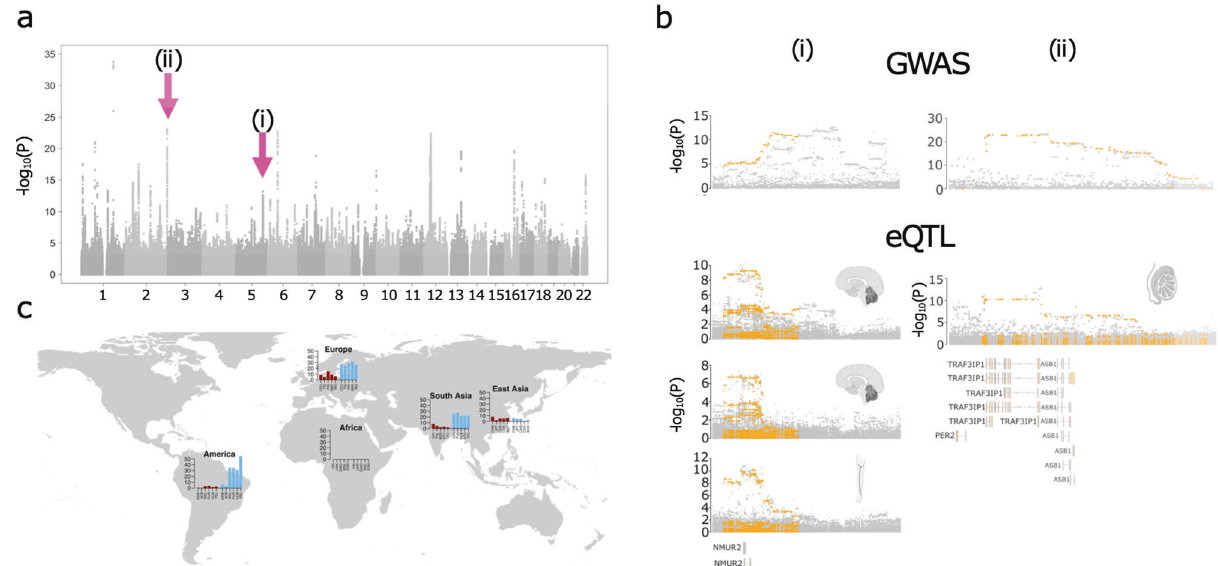
Fig. 3 Neandertal DNA contributes to chronotype risk loci. a Manhattan plot for a Chronotype GWAS in the UK Biobank. b Magni fi ed views of the association ( y -axis, − log 10 transformation of the association p value) score with chronotype on chromosomes 5 (left, chr5:151,589,813 – 152,689,813) and 2 (right, chr2:239,173,478 – 239,573,478) are shown on the top part of each panel. aSNPs are highlighted in orange. The lower part of each panel shows gene expression associations in GTEx tissues for the respective regions (eQTL − log [10] transformed association P values for — from top — Cerebellar_Hemisphere, Cerebellum and Tibial Nerve and Testis. Models of overlapping gene are illustrated at the bottom. c The frequency of the top associated aSNPs from the two illustrated regions (rs76939124, chr2:239,223,478 in red and rs4958550 , chr5:151,889,813 in blue) across 1000 Genomes